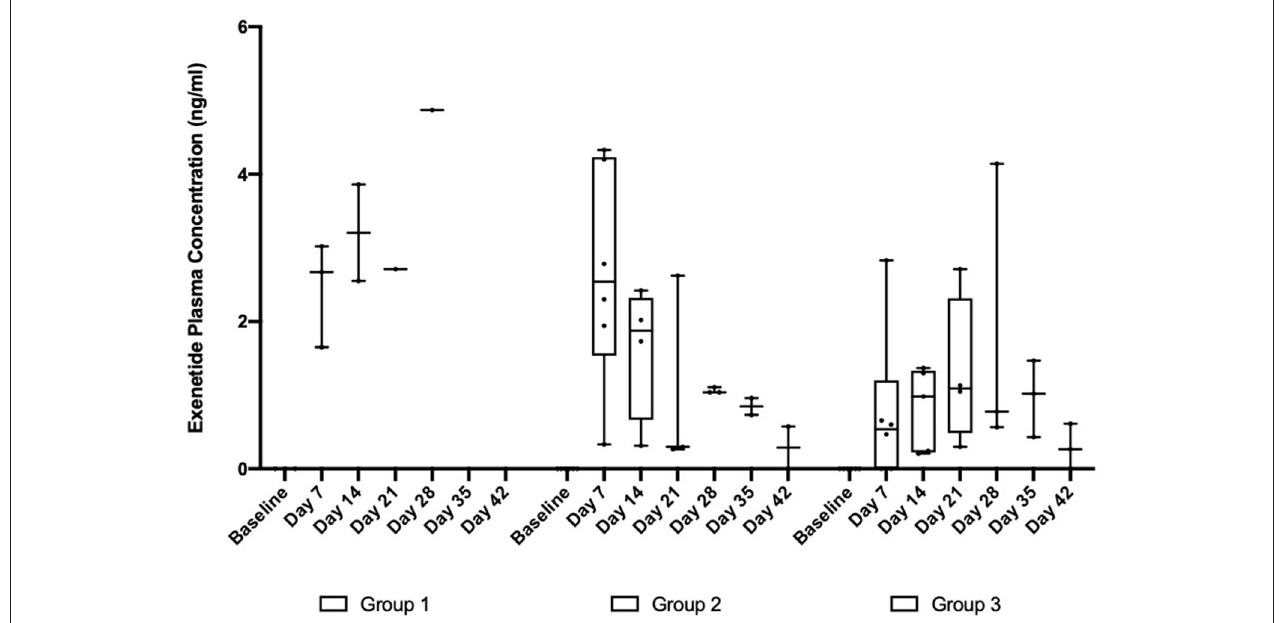
FIGURE 5 | Exenatide plasma concentrations in in healthy purpose-bred cats randomized to Group 1 ( n = 3, largest NanoPortal configuration, fast release), Group 2 ( n = 6, medium configuration), and Group 3 ( n = 6, thickest NanoPortal configuration, slow release). The horizontal line in each box represents the median, the lower and upper boundaries of the boxes the interquartile range, and the ends of the bars the minimum and maximum values.